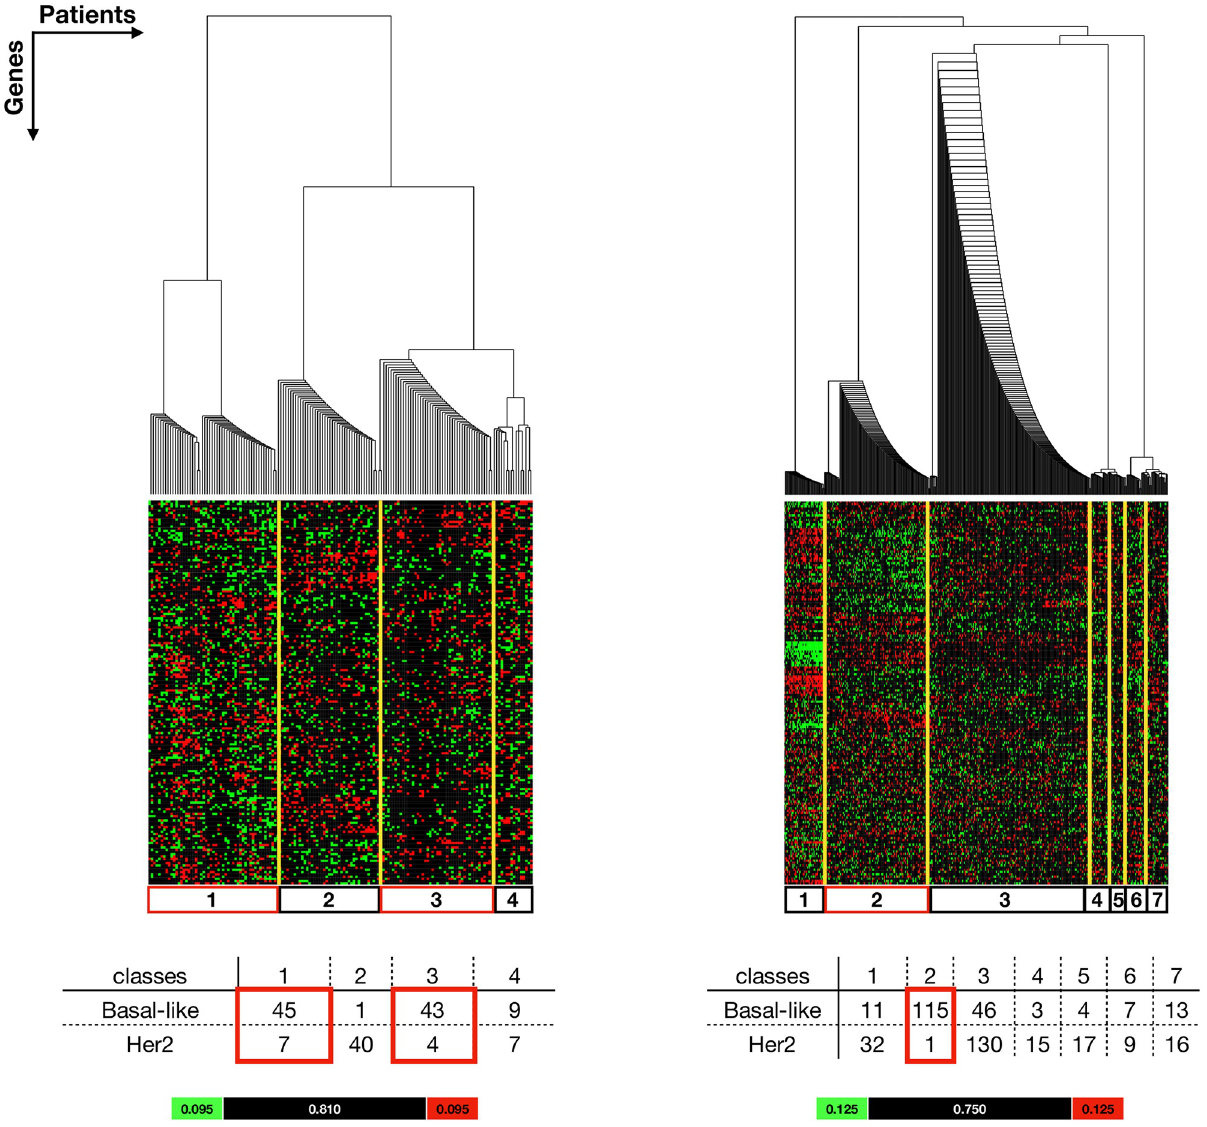
Fig 4. Extracted results from Basal-like vs Her2 comparison show a stratification of Basal-like vs Her2 patients (columns) according to the NR- associated gene expression signals (rows). See S3.4 and S3.5 Files in S3 Appendix for the complete results. Left: Patients from TCGA dataset were grouped into 4 classes. Class 1 and class 3 are considered as Basal dominant classes . Right: Patients from METABRIC dataset were grouped into 7 classes. Class 2 is considered as a Basal dominant class . Yellow lines highlight the classes (simplified from the clusters) and the corresponding expression pattern in the colour plot. The tables show the number of Basal-like and Her2 patients in each class. The Basal dominant classes are highlighted in red boxes in the table and colour plots. The colour bar indicates the lowerbound (green), likelihood (black) and upperbound (red).